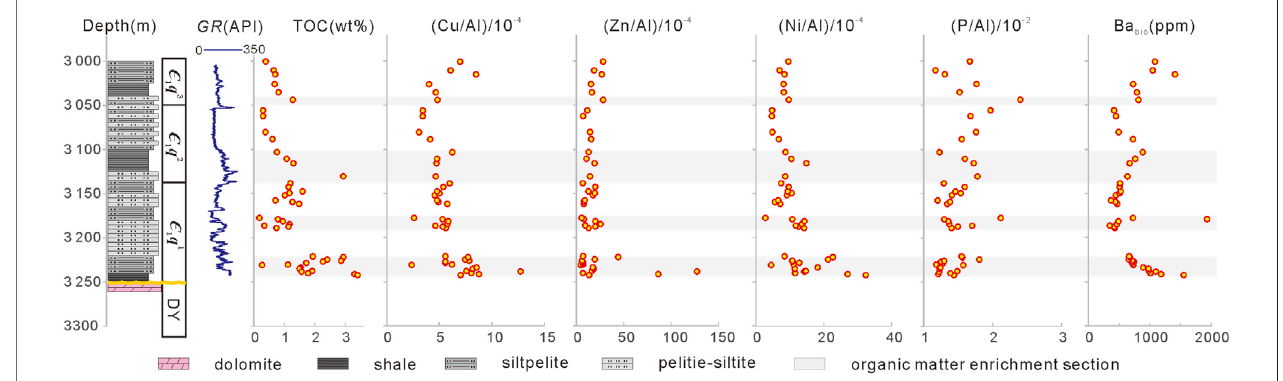
FIGURE8| Characteristicsofpaleo-oceanproductivityparametersoftheQiongzhusiFm,W-207Well. Є 1 q 1,2,3 : fi rst,secondandthirdmemberofQiongzhusiFm.